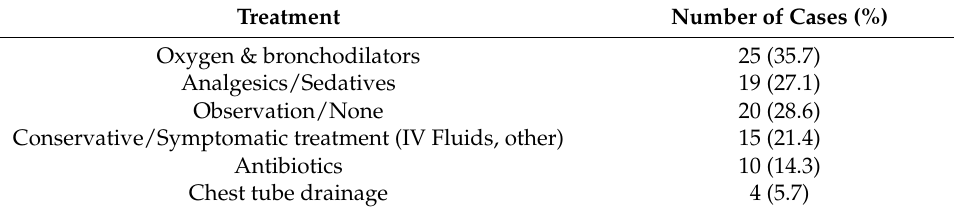
Table 4. Treatment in pregnancy-associated SPM (Total number = 70. Not reported = 10).